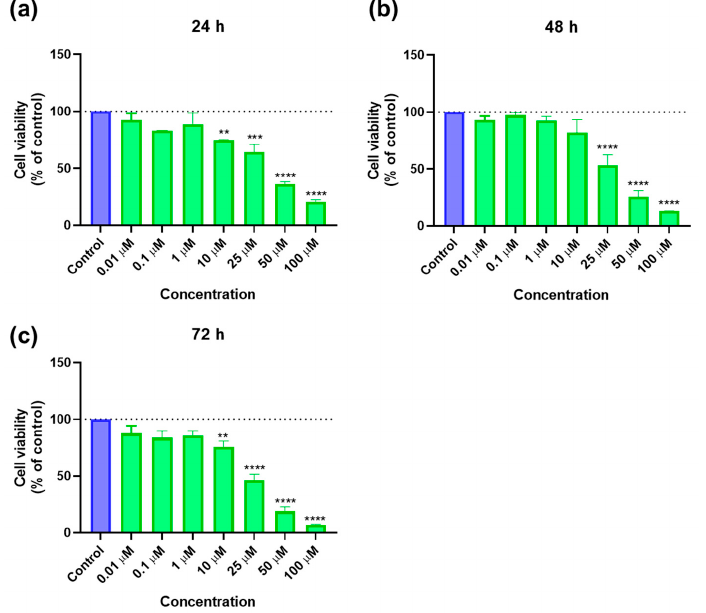
Figure 4. Cytotoxic results of PC-3 after exposure to increasing concentrations of saquinavir (0.01– 100 μ M) for 24 h ( a ), 48 h ( b ), and 72 h ( c ). Control cells were treated with 0.01% DMSO (vehicle). Cell viability was obtained using the MTT assay and the results are given as the mean ± SEM (24 h n = 3, 48 h, and 72 h n = 6). ** statistically significant vs. control (vehicle) at p < 0.01; *** statistically significant vs. control (vehicle) at p < 0.001; **** statistically significant vs. control (vehicle) at p < 0.0001.